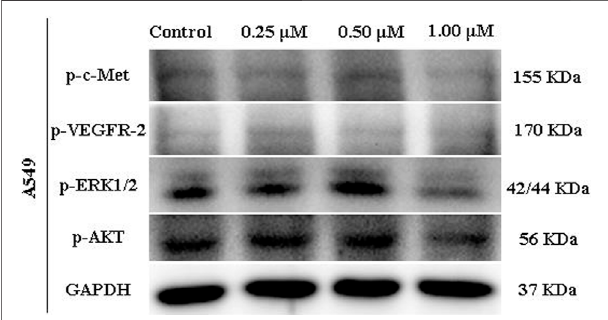
FIGURE 6 | c-Met biomarker modulation by compound 17l (Evaluated by Western